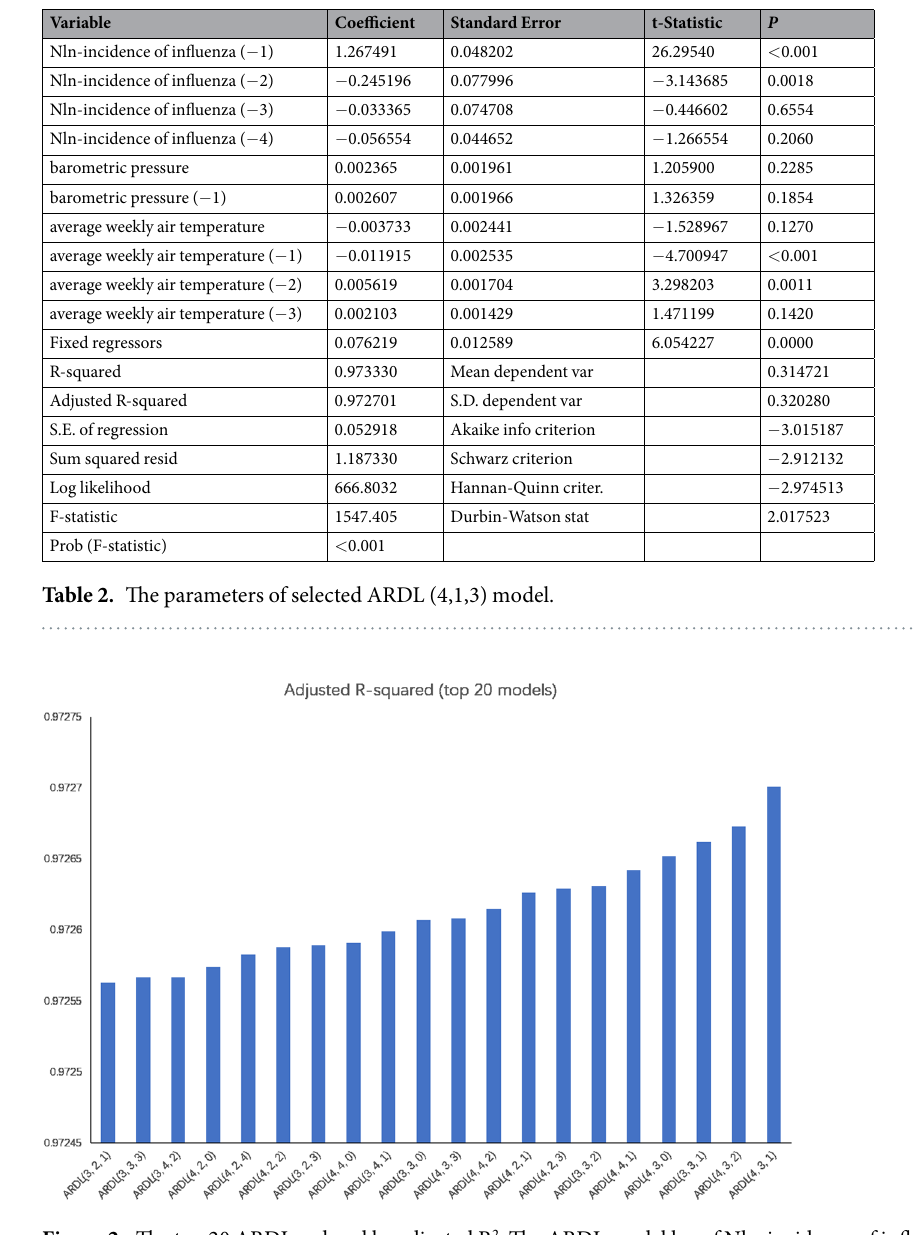
Figure 2. The top 20 ARDL ordered by adjusted R 2 . The ARDL model lag of Nln-incidence of influenza was four, the lag of weekly average barometric pressure was one and the lag of weekly average air temperature was three. The adjusted R 2 value was chosen to determine the optimal lag order of the variables in ARDL